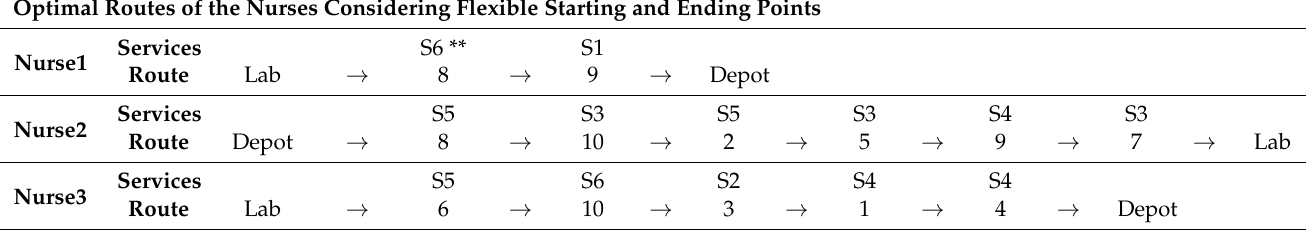
Table 2. Optimal routes considering flexibility in the model (the proposed model).